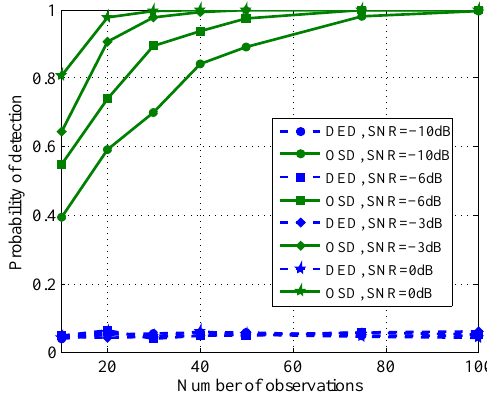
Figure 7. Probability of detection: DED and OSD vs. M for different SNRs | Rayleigh fading | Laplacian noise | Gaussian primary